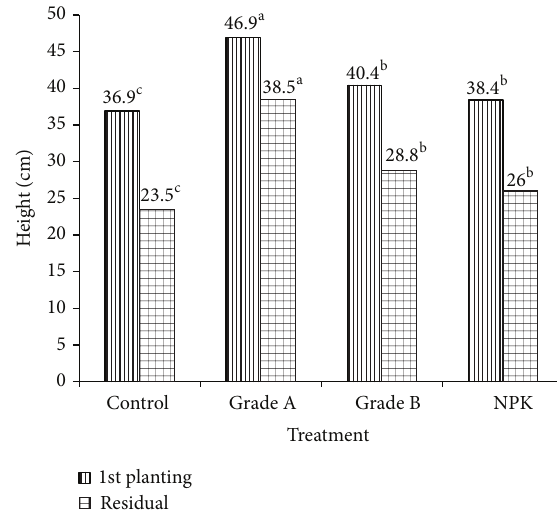
Figure 1: Plant height of Amaranthus caudatus as influenced by application of organic fertilizers and NPK at 4 weeks after trans- planting. Means having the same letter along the columns indicate no significant difference using Duncan’s multiple range test at 5% probability level.